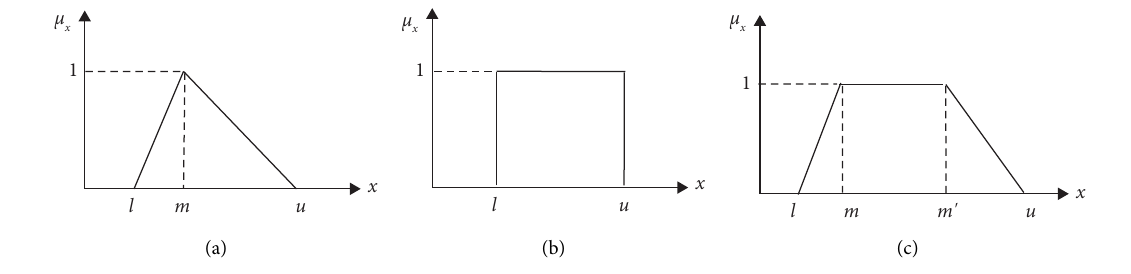
Figure 2: Membership function of three common FNs. Table 1: Comparing TrFNs using the ED and the COG